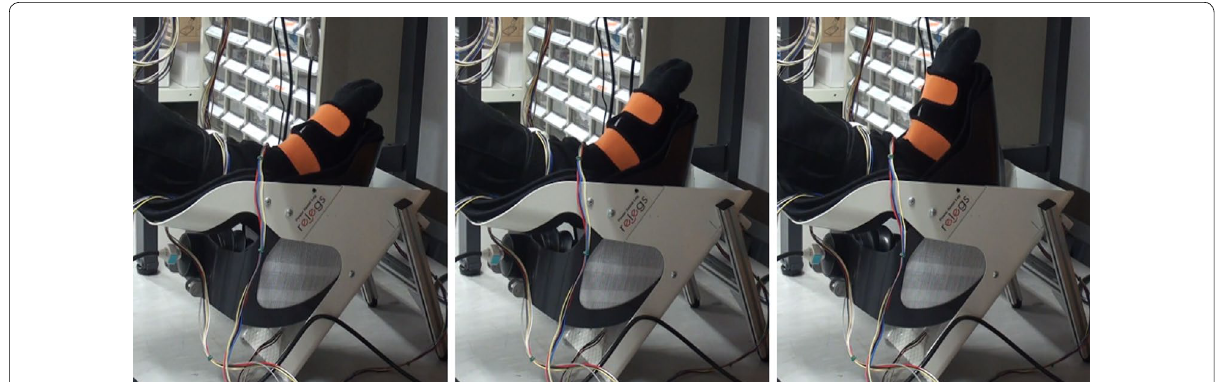
Fig. 3 Scenes of stretching. Left: In the initial stage, the foot is relaxed. Middle: In the middle stage, the foot is being dorsiflexed slowly. Right: In the final stage, the foot is maintained in the dorsiflexed